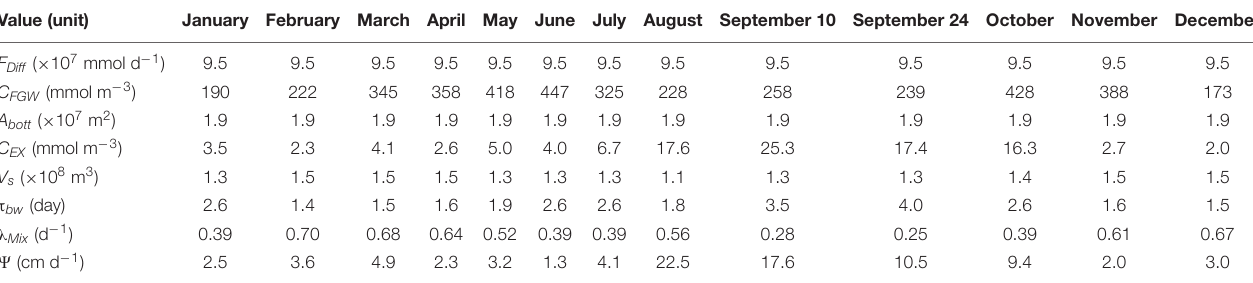
TABLE 1 | Values for each notation in the dissolved silicon (DSi) mass balance model in Hwasun Bay, Jeju Island. Value (unit)